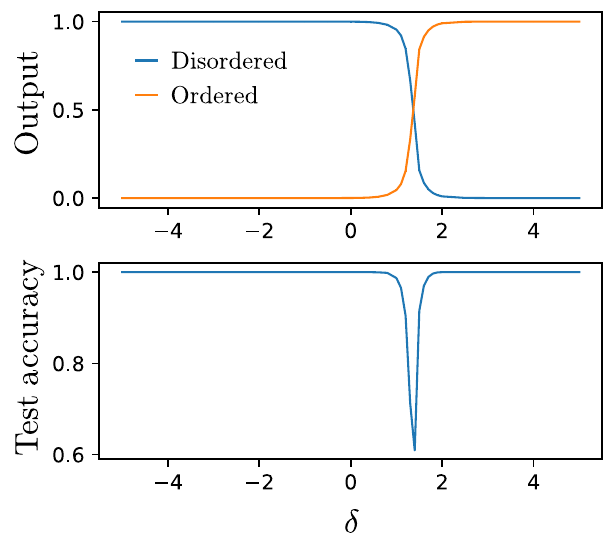
FIG. 3. Learning the quantum phase transition in the Rydberg- atom array. Top: Output signal for the two units in the topmost dense layer of the neural-network architecture as a function of the detuning, corresponding to Eq. (5). Bottom: Accuracy on the test dataset, showing a dip near the critical point. This estimator is calculated by comparing the prediction of the CNN with the correct labels assigned to the samples in the test